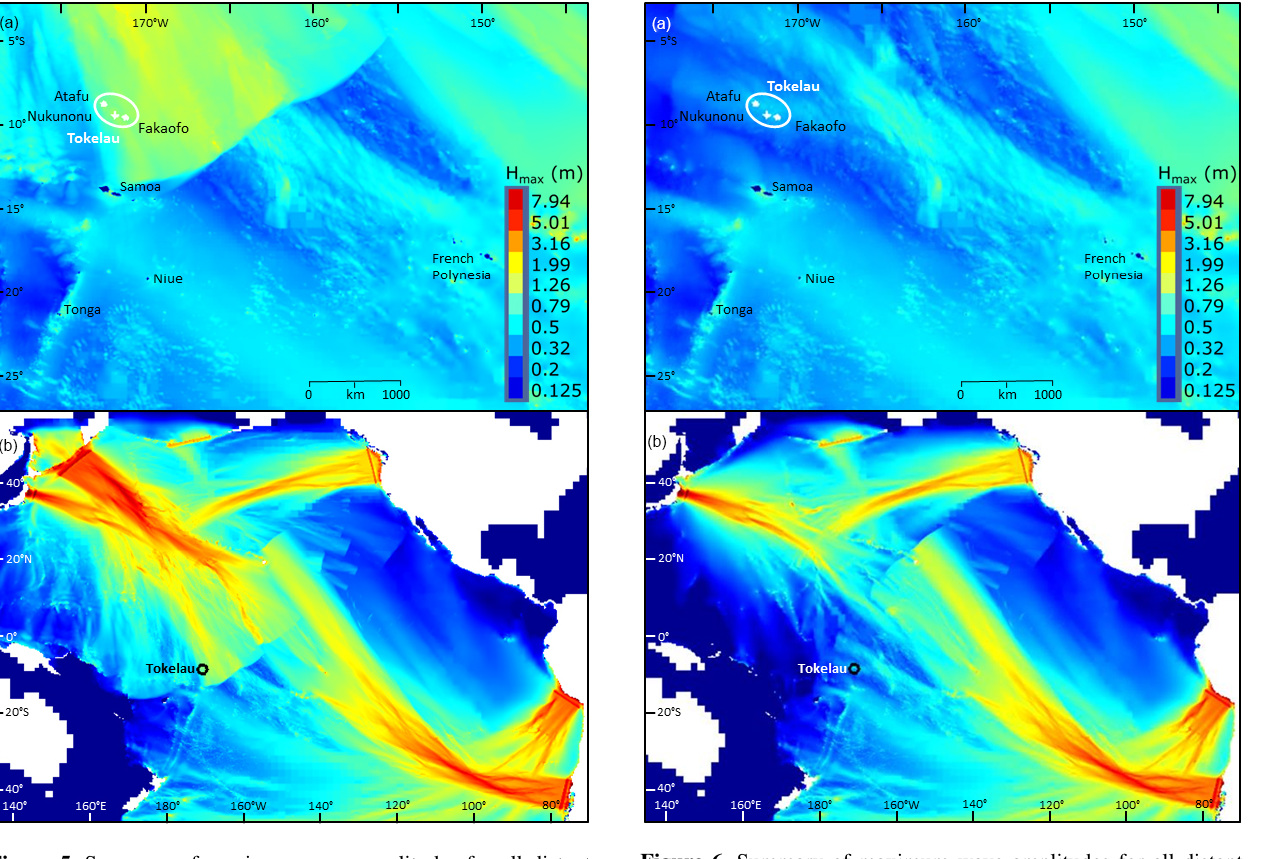
Figure 5. Summary of maximum wave amplitudes for all distant sources. The top frame (a) provides a regional focus of the south- western equatorial Pacific, with the Tokelau Islands outlined in white. The lower frame (b) provides a wider view of the Pacific Ocean and the distant, trans-Pacific tsunami source regions, with the Tokelau Islands outlined in black. Note that simulations stop after the majority of the tsunami-wave train has passed Tokelau, giving a truncated appearance to farthest extents of the wave fields. The height is plotted on a logarithmic scale (same for both images) to adequately capture the wide range of wave amplitudes in both frames (0.125m in dark blue to over 7.9m in red).